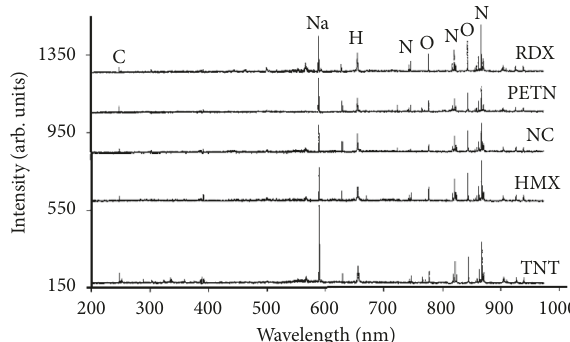
Figure 11: LIBS spectra of different types of pure explosive compounds (adapted from [172]).